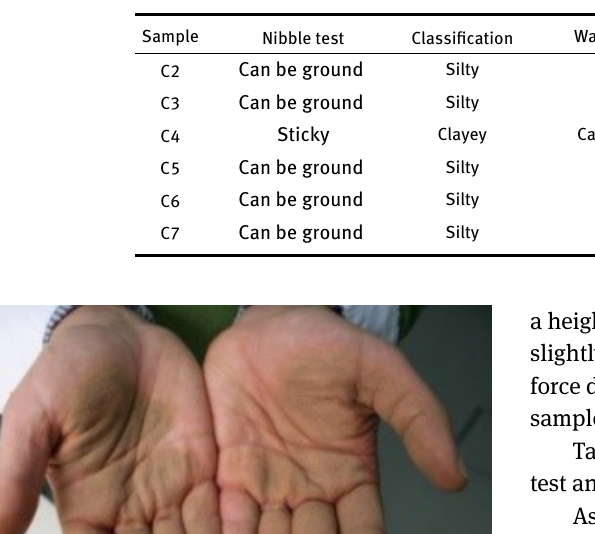
consistency test, a moist portion of each EBM sample is formed into a 3 cm ball diameter so that it sticks together but does not stick to the fingers, Figure 6 illustrates these ball samples.